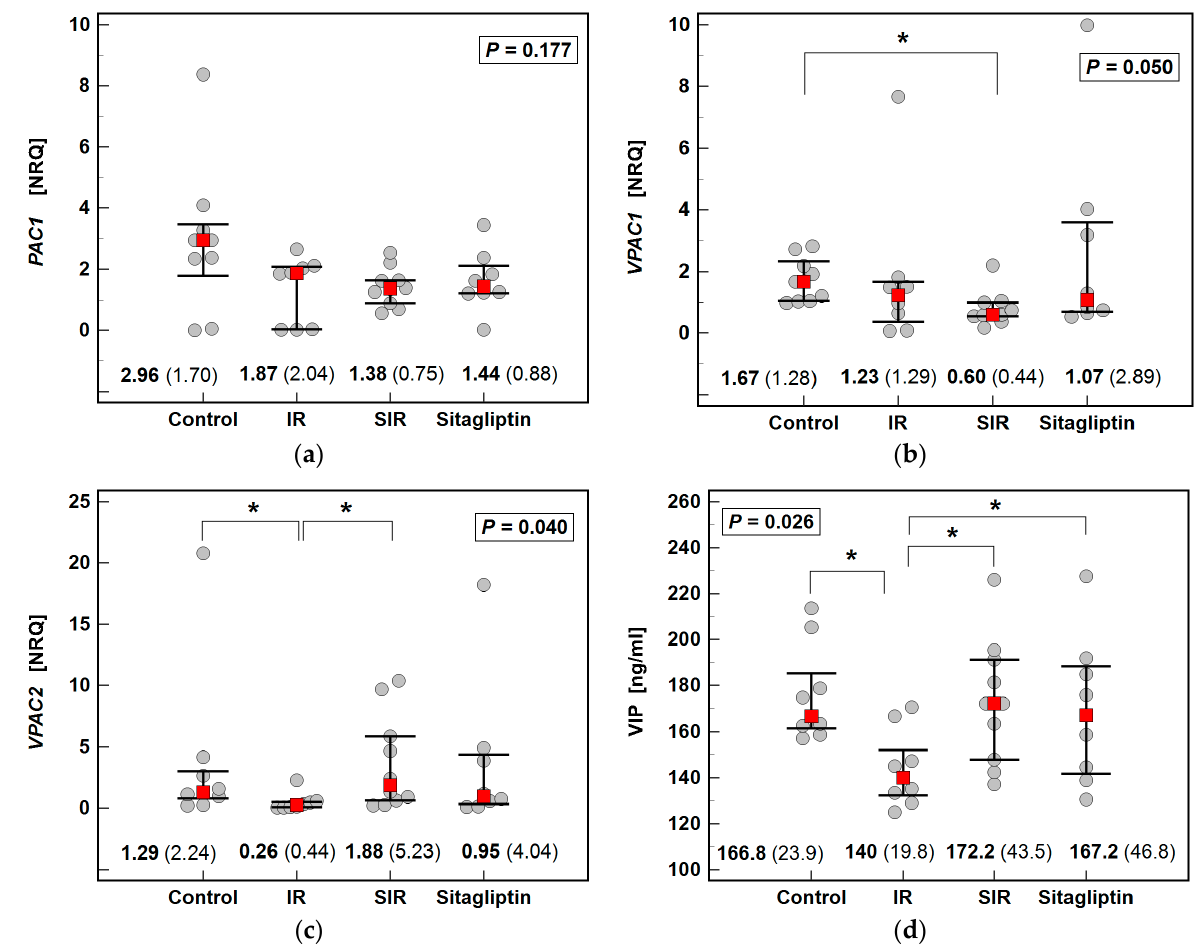
Figure 2. Effect of IR injury and sitagliptin on CXCR4/SDF1 axis in the liver: ( a ) Cxcr4 expression; ( b ) CXCR4 concentration; ( c ) Sdf1 expression; ( d ) SDF1 α concentration. Data were analyzed using the Kruskal–Wallis H test and are presented as medians with IQR (red squares with whiskers and numbers below dot-plots). Significant ( p < 0.05) differences between groups, identified in post-hoc analysis (Conover test), are indicated by connectors with * symbol. NRQ, normalized relative quantity; IR, ischemia-reperfusion; SIR, sitagliptin pretreatment and ischemia-reperfusion; IQR, interquartile range.